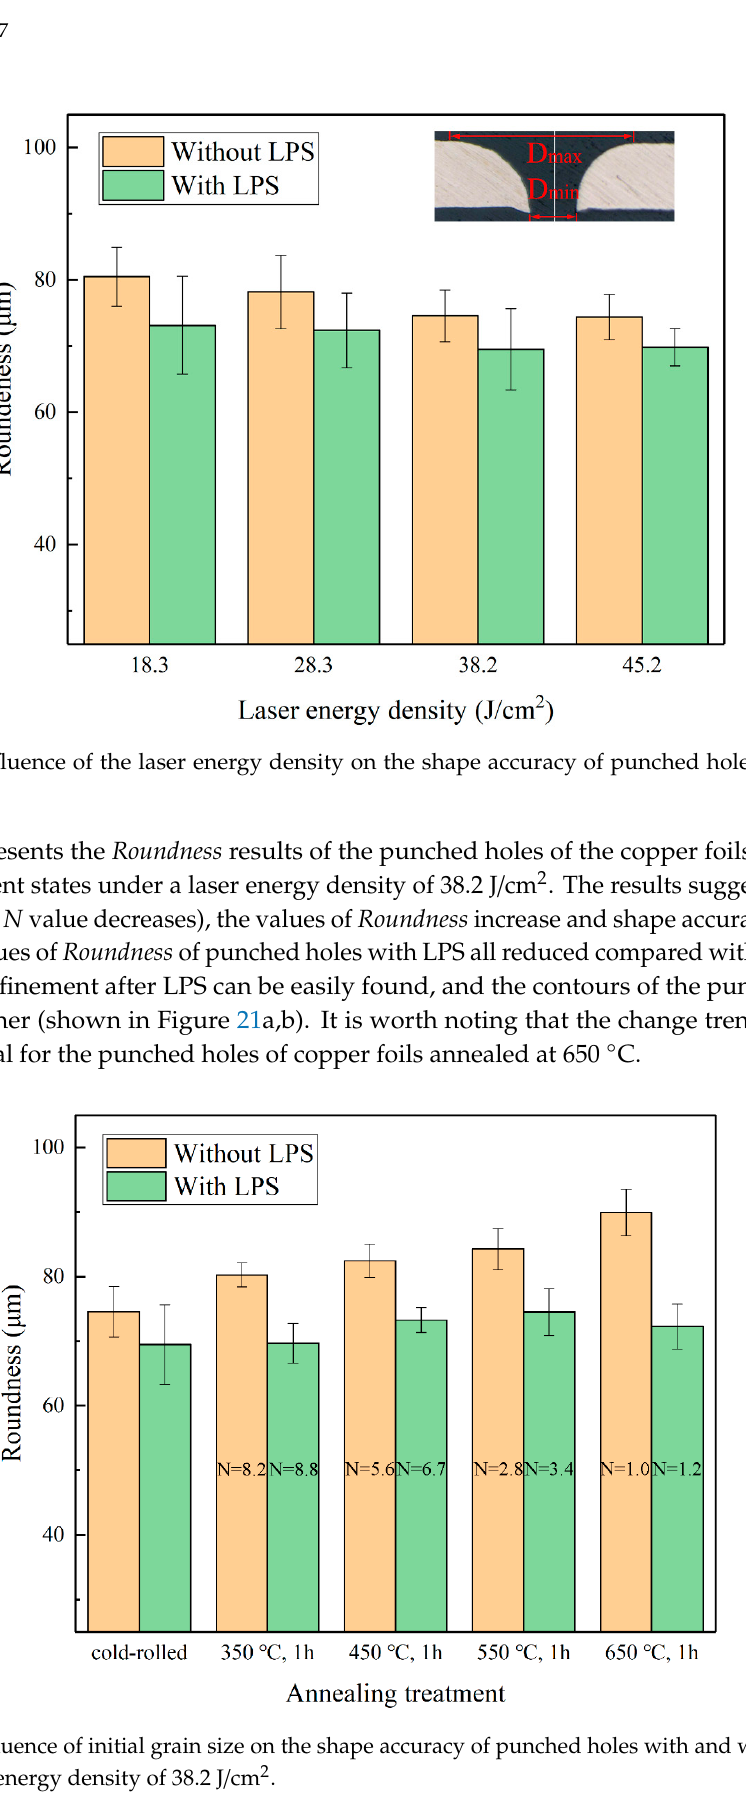
18 of 24 Figure 18. Comparison of punched holes without LPS under different conditions (bottom surface). ( a ) Cold-rolled; ( b ) 450 °C annealed, 1 h; ( c ) 550 °C annealed, 1 h; ( d ) 650 °C annealed, 1 h. Figure 19 presents the 𝑅𝑜𝑢𝑛𝑑𝑛𝑒𝑠𝑠 results of the punched holes of cold-rolled copper foils with and without LPS punched under different laser energy density conditions. It can be found that laser energy density has little effect on the shape accuracy of punched holes, because the average values of 𝑅𝑜𝑢𝑛𝑑𝑛𝑒𝑠𝑠 of punched holes without LPS vary from 74.4 to 80.5 µm, and those with LPS vary from 69.5 to 73.2 µm. Meanwhile, under the same laser energy density condition, the values of 𝑅𝑜𝑢𝑛𝑑𝑛𝑒𝑠𝑠 of punched holes with LPS are further reduced, thereby indicating that LPS is beneficial to obtain improved shape accuracy. This finding may be because LPS refines the internal grains of copper foils, as shown in Figure 3. Figure 20 presents the 𝑅𝑜𝑢𝑛𝑑𝑛𝑒𝑠𝑠 results of the punched holes of the copper foils with different